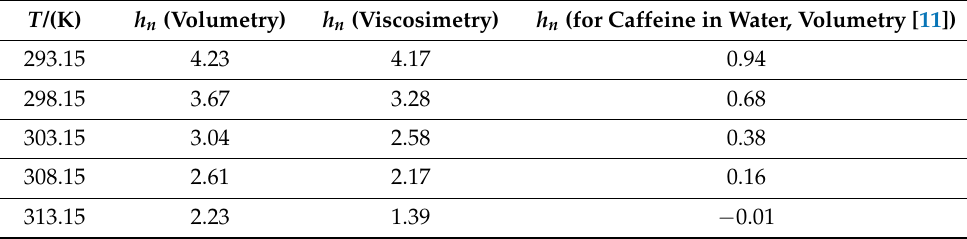
Table 8. Values of caffeine hydration numbers gathered from volumetry and viscosimetric measure- ments in aqueous solution and 0.1 mol · kg − 1 SS aqueous solutions in the temperature range from T = 283.15 to 313.15